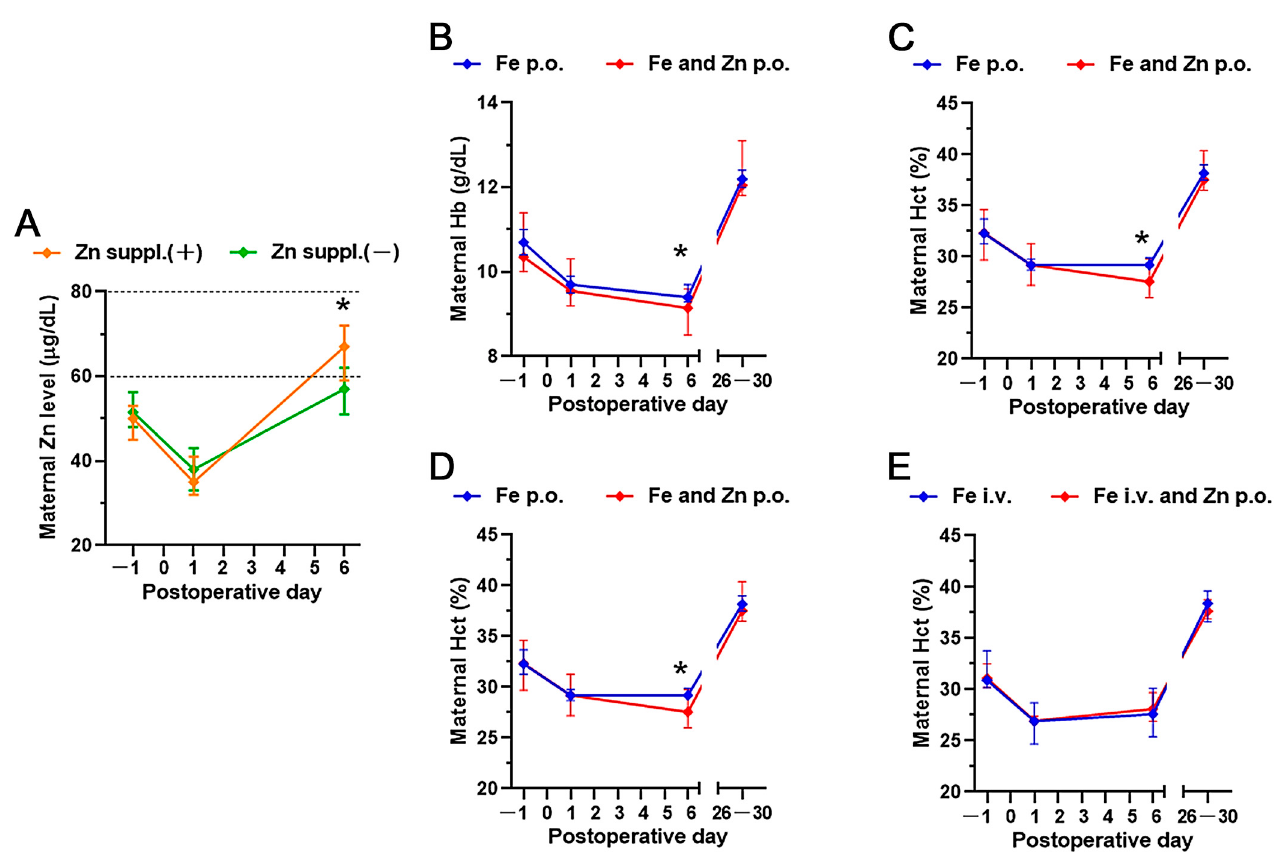
Figure 2. Perioperative trends of zinc, hemoglobin, and hematocrit after zinc supplementation or not. The median values of ( A ) maternal serum zinc, ( B , D ) hemoglobin, and ( C , E ) hematocrit are displayed (error bar: 95% confidence interval). The data were analyzed using the Mann–Whitney U-test on each evaluation day, and the asterisk means p < 0.05. suppl, supplementation; p.o., per os; i.v., intravenous medications; Hb, hemoglobin; Hct, hematocrit.